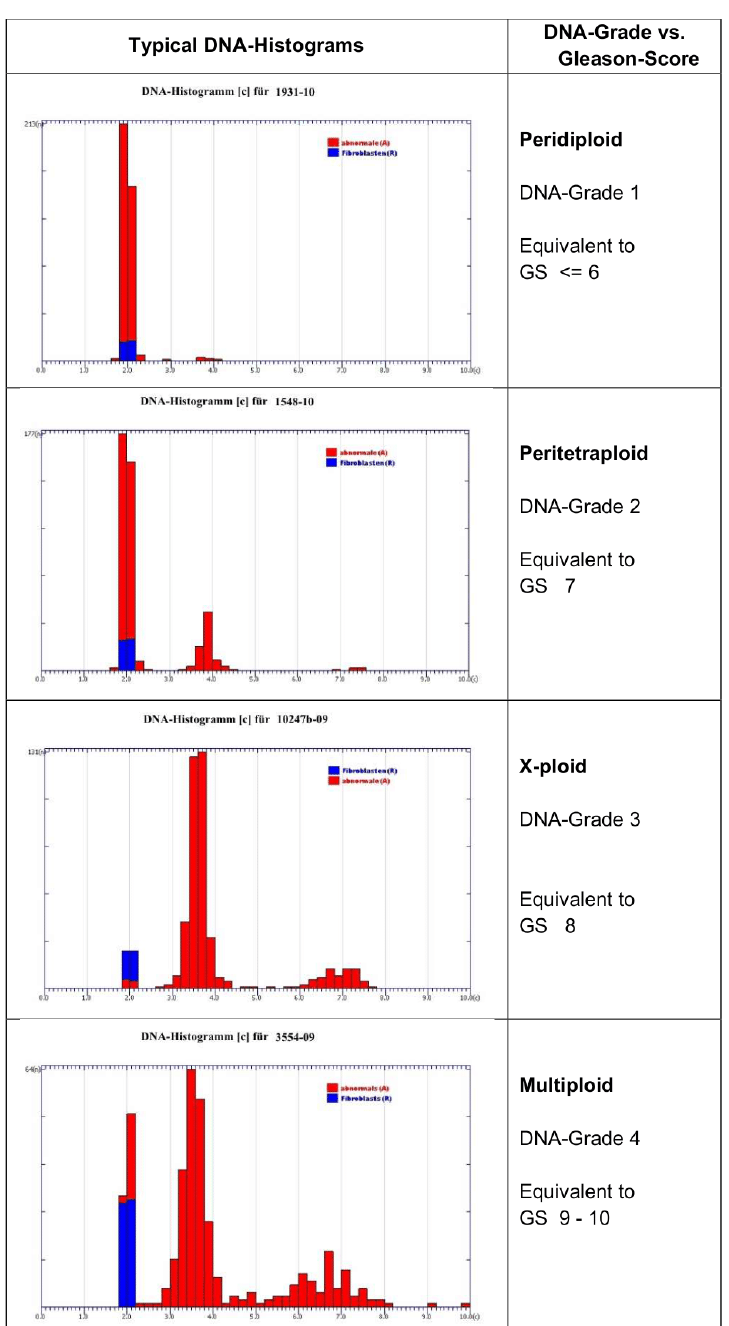
Figure 2. DNA histograms of four prognostically different DNA grades of malignancy in prostate cancers (grade 1 = peridiploid, grade 2 = peritetraploid, grade 3 = x-ploid, grade 4 = multiploidy), from Böcking et al. [18].